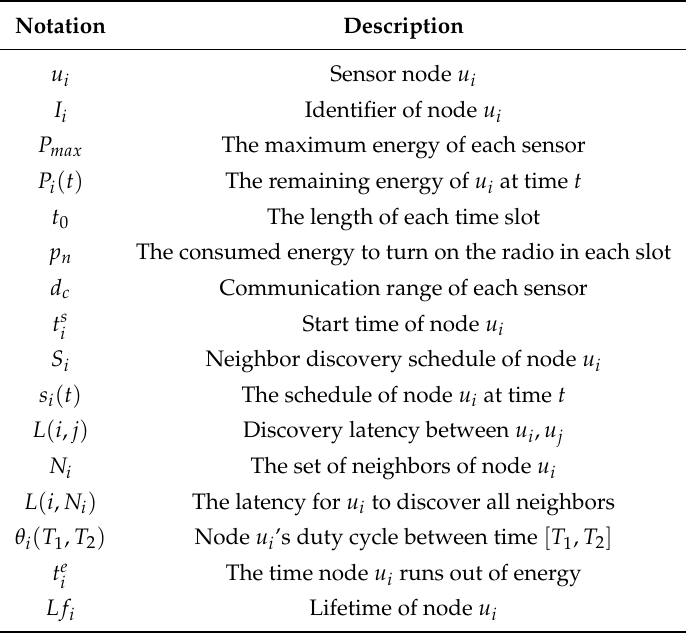
Table 1. Notations for Neighbor